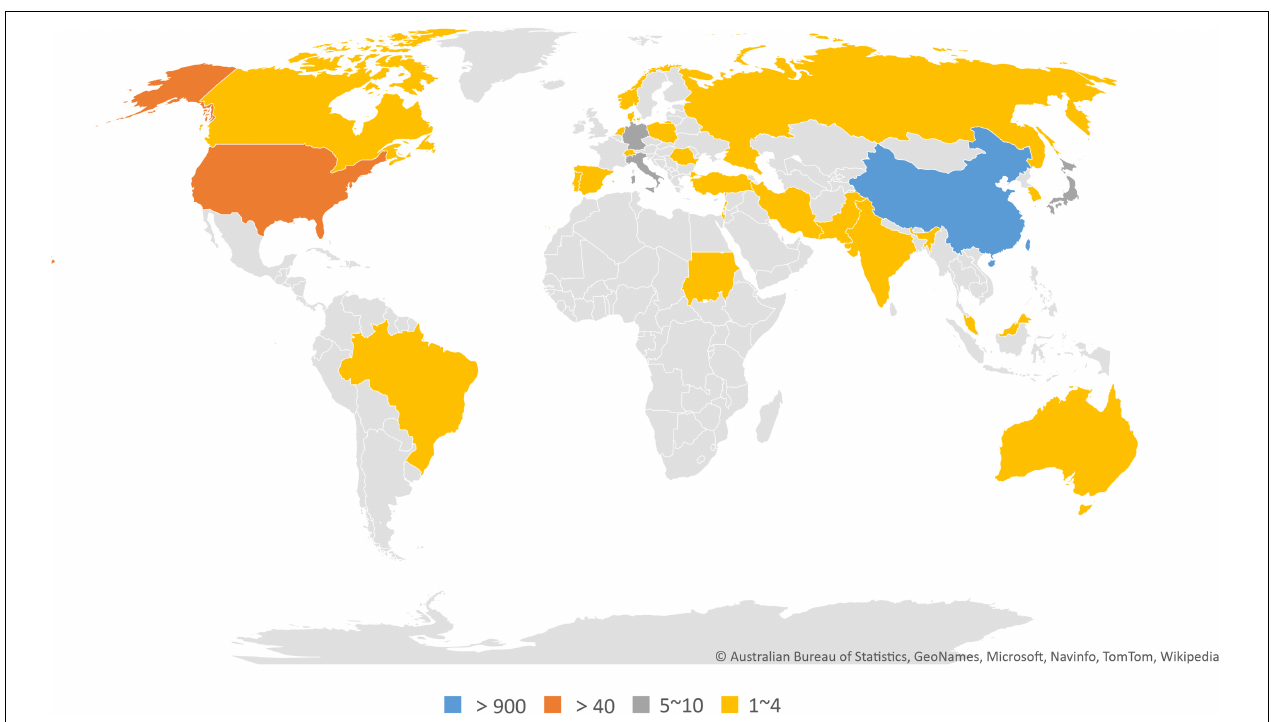
FIGURE 4 | World map of countries/regions that published articles on the crosstalk between microRNAs and circular RNAs.